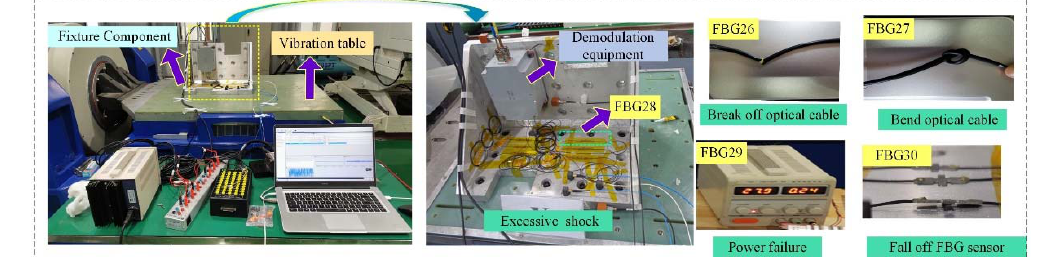
Figure 7. Simulation setup of typical faults on FBG sensors.